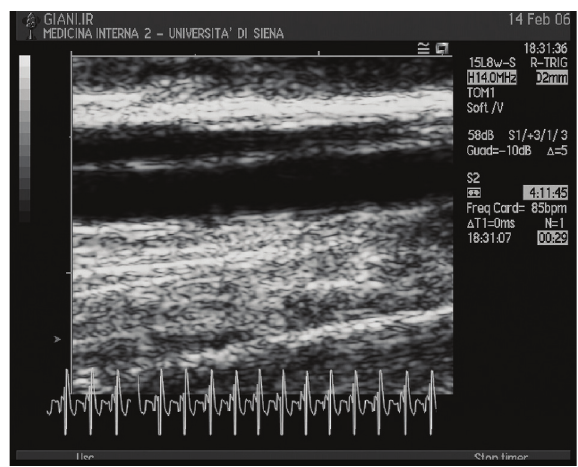
Figure 1: Typical FMD image resulting from the echo scanner.